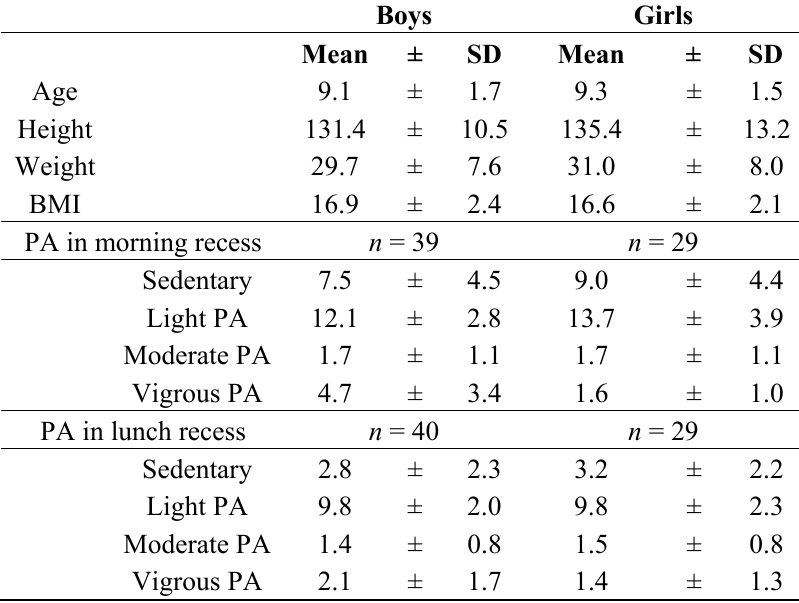
Table 1. Descriptive characteristics by gender (numbers and